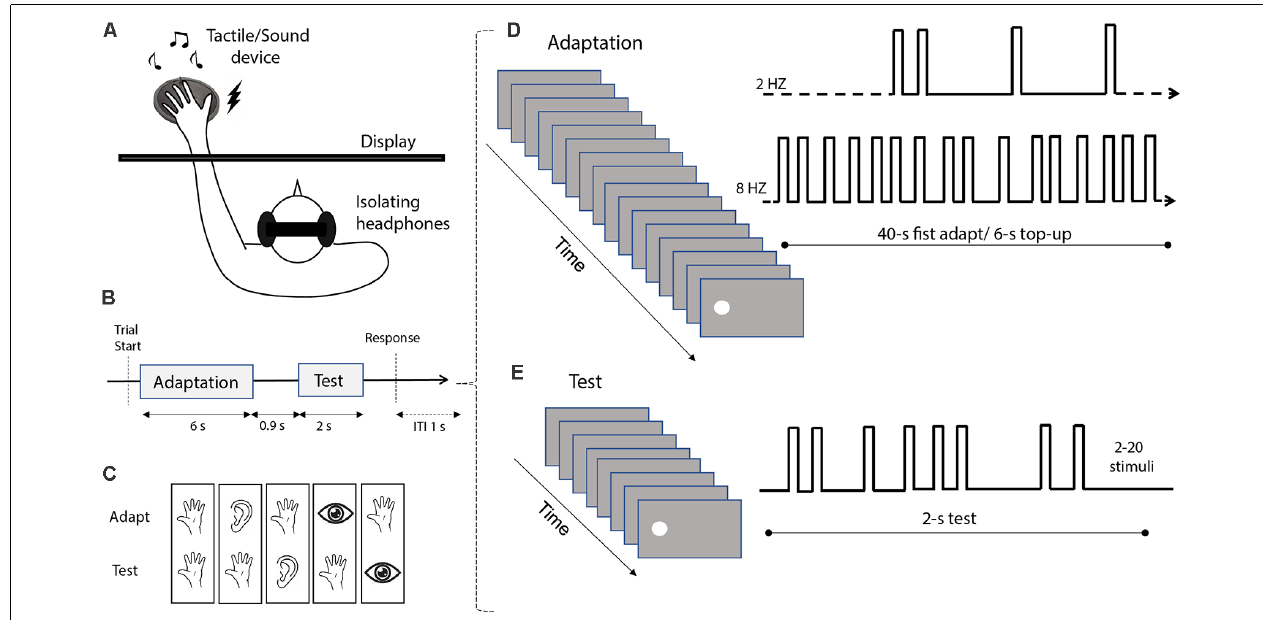
FIGURE 1 | Stimuli and experimental procedure. (A) Schematic depiction of the experimental setup. Participants seated in front of a monitor screen, with their hands positioned on the audio-tactile device located behind the screen. To avoid receiving auditory feedback during tactile stimulation, the subjects wore isolating headphones. (B) Depiction of the trial sequence. Each trial included an adaptation phase (6 s; with the exception of the first trial where the adaptation duration was 40 s) followed by a test phase (2 s), with an inter-stimulus interval of 0.9 s. At the end of each trial, participants were asked to estimate the numerosity of the test stimulus. After providing a response, the next trial started after an inter-trial interval (ITI) of 1 s. (C) The different combinations of adaptation and test stimulus modality (from left to right: tactile-tactile, audio-tactile, tactile-audio, visual-tactile, and tactile-visual). (D) Example of the adaptation sequence. Two different types of adaptation were tested in each condition: “low” adaptation, involving stimulation at 2 Hz, and “high” adaptation, involving stimulation at 8 Hz. In the first trial, adaptation was delivered for 40 s, while in each following trial we delivered a “top-up” adaptation of 6 s. (E) Example of the test stimulus sequence. Each test sequence included 2–20 individual stimuli, delivered within an interval of 2 s. Note that these examples depict the presentation of visual adaptor or test stimuli, but in different conditions, the sequences could involve also sounds or vibrotactile pulses. The examples are not depicted in